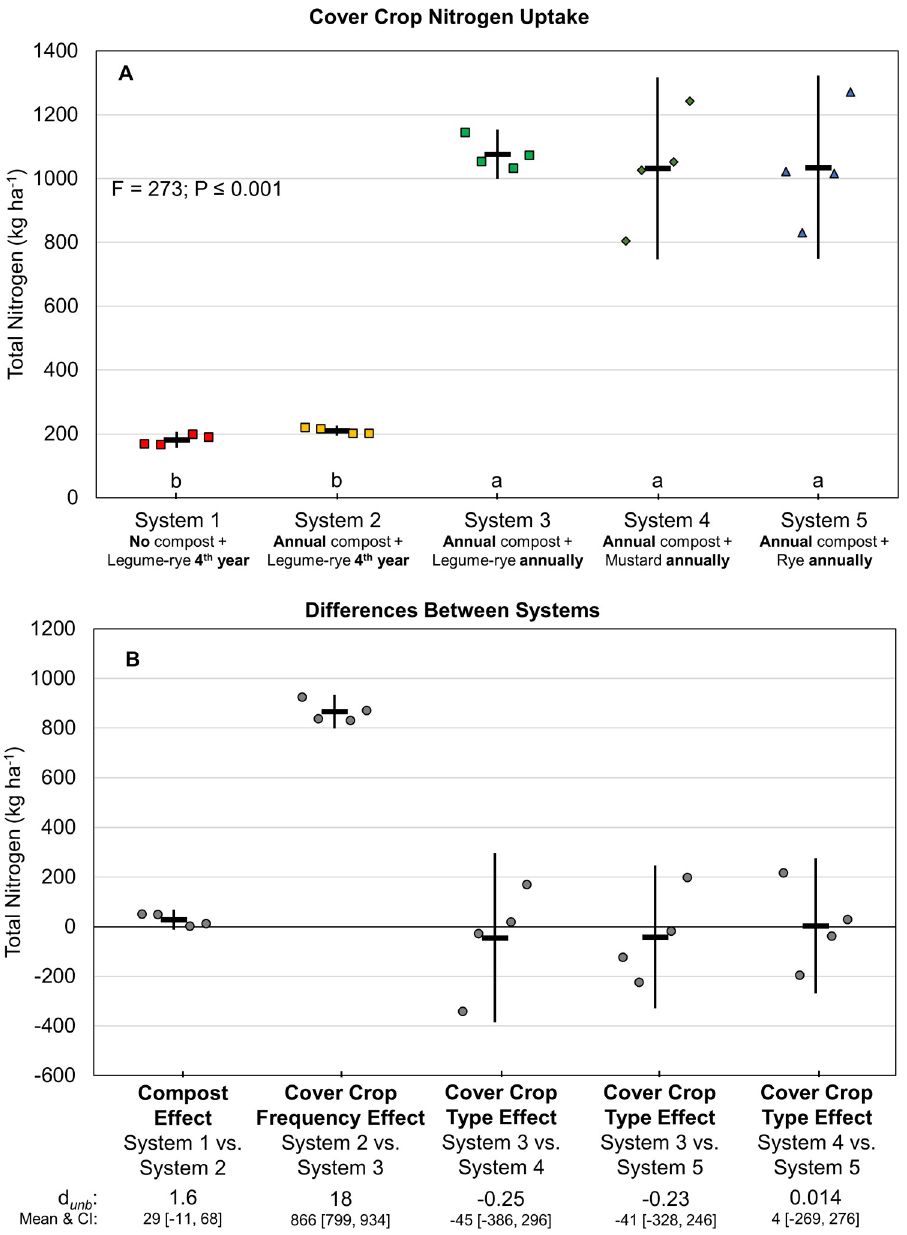
Fig 5. Cumulative above ground and estimated below ground cover crop nitrogen uptake over eight years of vegetable production. Mean nitrogen uptake (A) and mean paired differences between systems (B) in 5 organic vegetable systems. Systems differed by annual compost additions, cover crop type and cover cropping frequency. Nitrogen uptake data does not include nitrogen from legume nitrogen fixation in Systems 1, 2 and 3; see Table 3 for nitrogen fixation data. Error bars are 95% confidence intervals (CI) around the mean (horizontal line). Data points are replicates 1 through 4 averaged across years and are clustered around the mean left to right so as not to obscure the mean and CI. Different lower-case letters above the x-axis in plot A indicate that means are significantly different based on the Tukey-Kramer adjusted family-wise error rate of P � 0.05. The standardized effect size (Cohen’s unbiased d , d unb ) is shown below the x-axis in plot